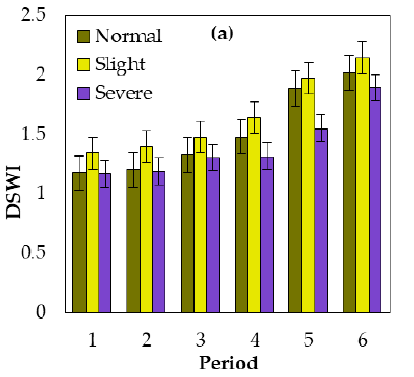
Figure 2. Flowchart for constructing monitoring models for powdery mildew using Landsat-8 imagery at regional scales.